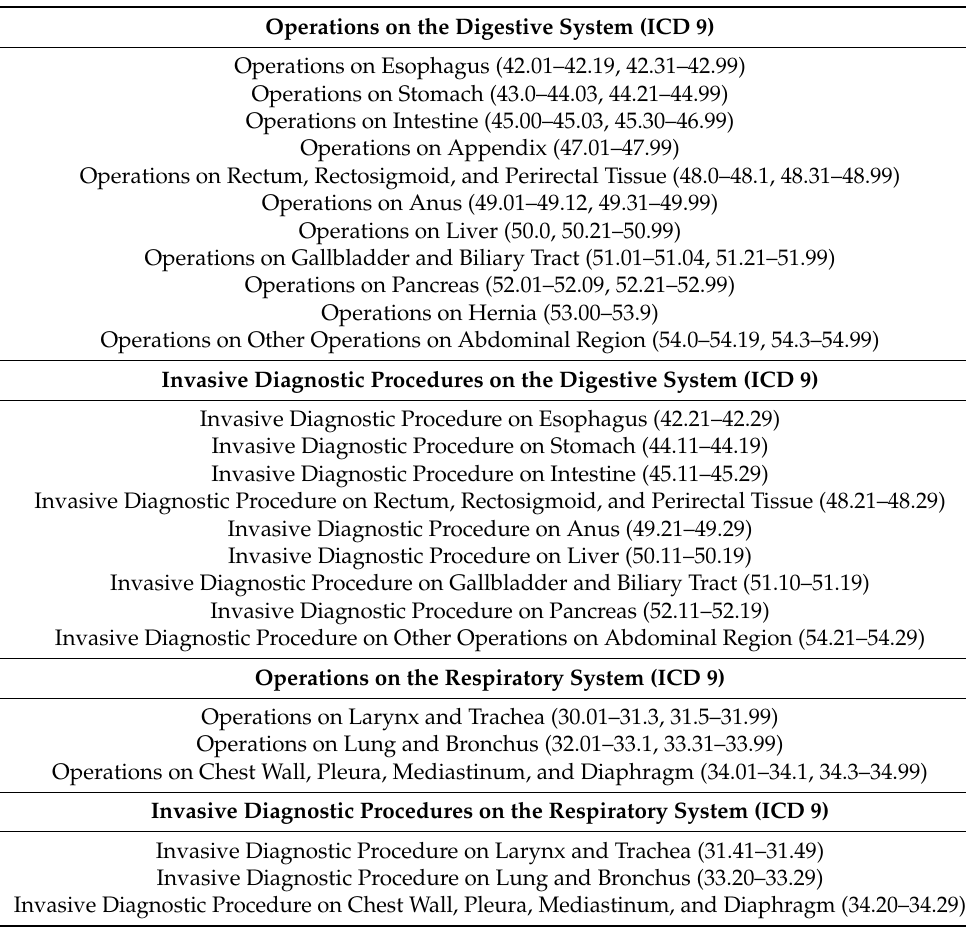
Table 1. Procedures of emergently admitted patients with the primary diagnosis of tracheostomy